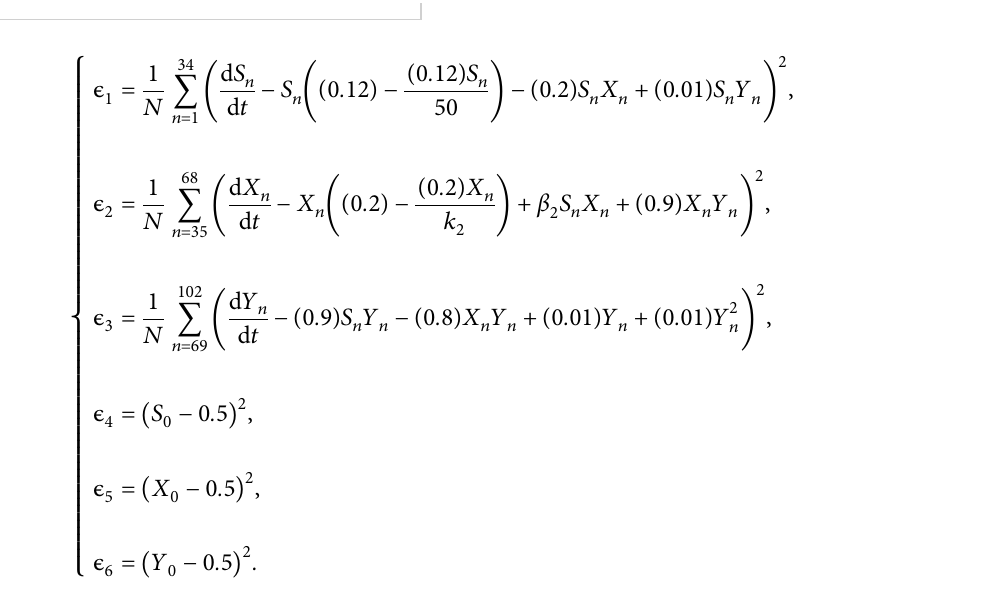
Table 19: Convergence analysis of population density of local, immigrant prey, and predator under the influence of variations in β FIT MAD TIC Cases